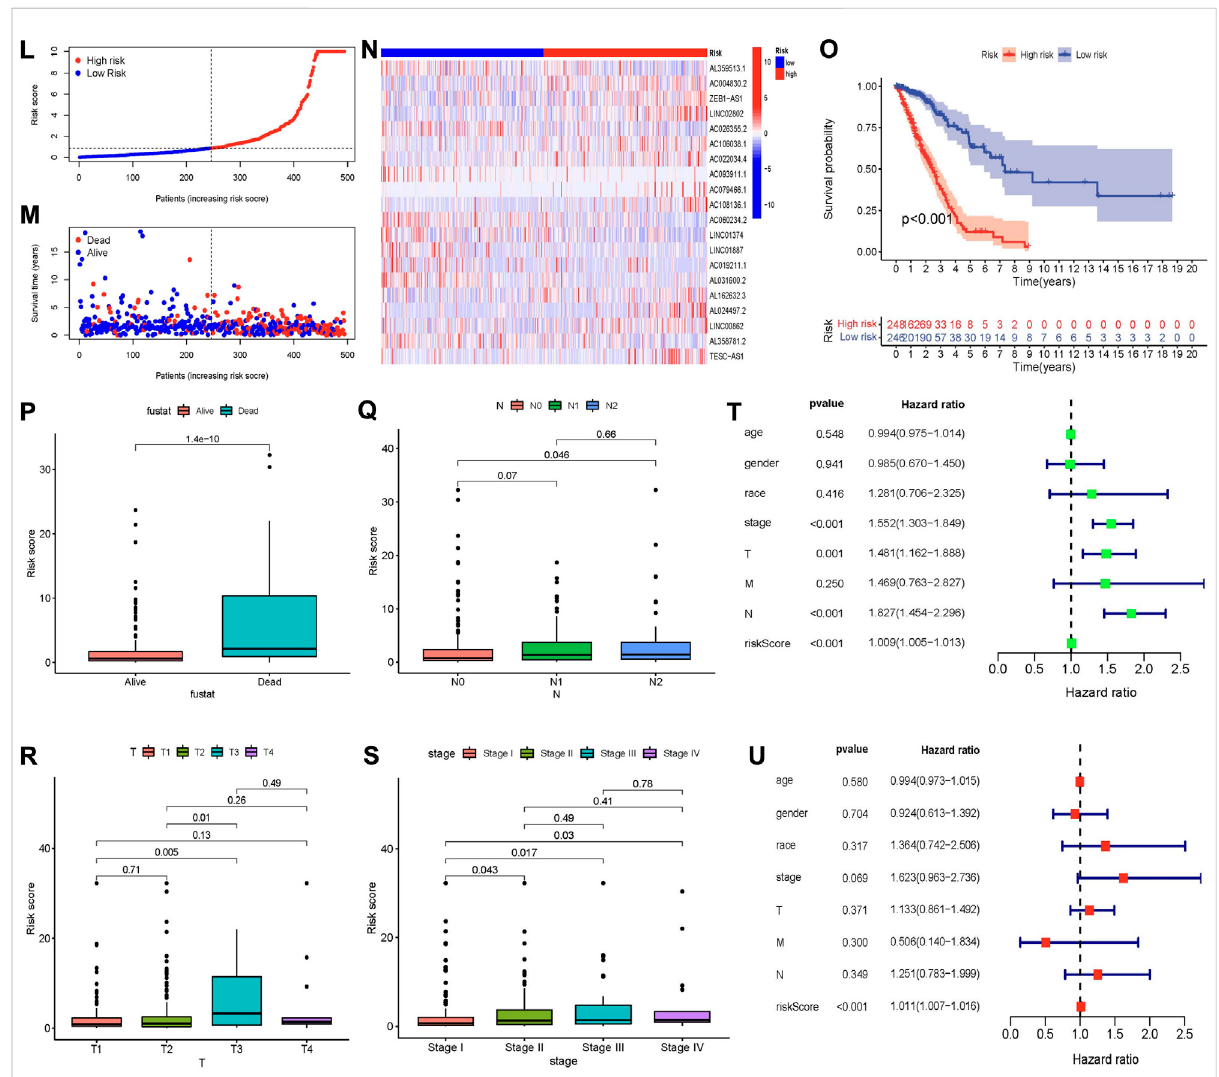
candidate genes. The 16 candidate genes were used to construct prognostic models. To construct risk characteristics and calculate risk scores, the coef fi cients and expressive values of MCRLncs screened out from LASSO regression were used to calculate an individual risk score. The risk score represents a prognostic feature of chaperone- related lncRNAs, which helps us to distinguish high-risk LUAD patients from low-risk LUAD patients. Our risk score calculation formula is as